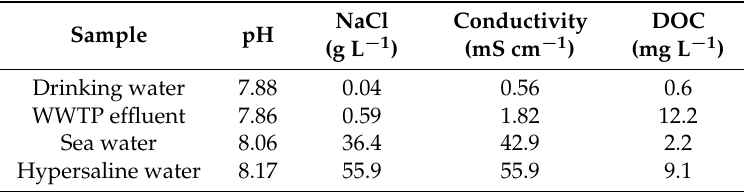
Table 1. Composition of collected natural water samples used for extraction experiments. WWTP: wastewater treatment plant, DOC: dissolved organic